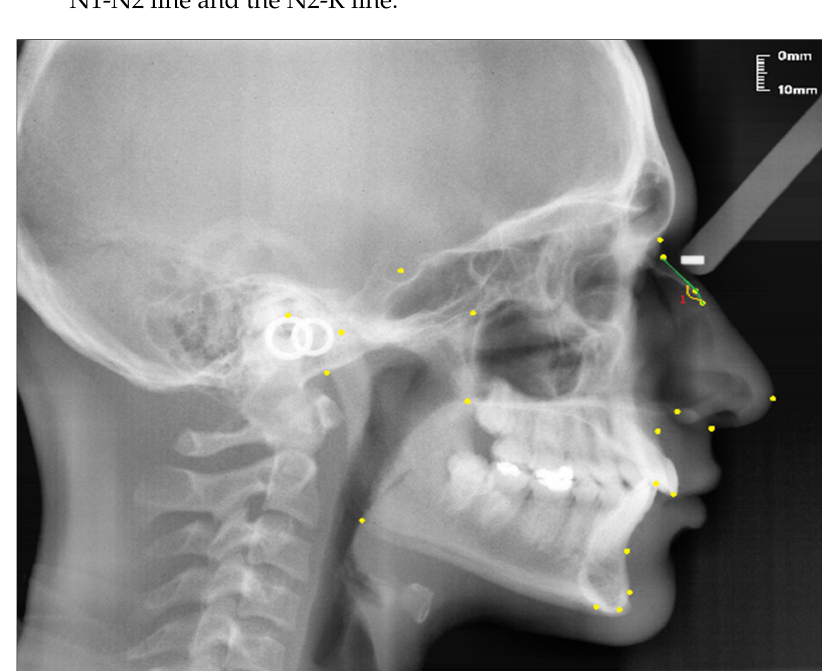
Figure 2. Linear measurements of the nasal profile used in the study.